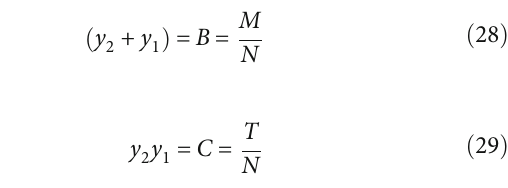
ffiffiffiffiffiffiffiffiffiffiffiffiffiffiffi p B 2 − 4 C